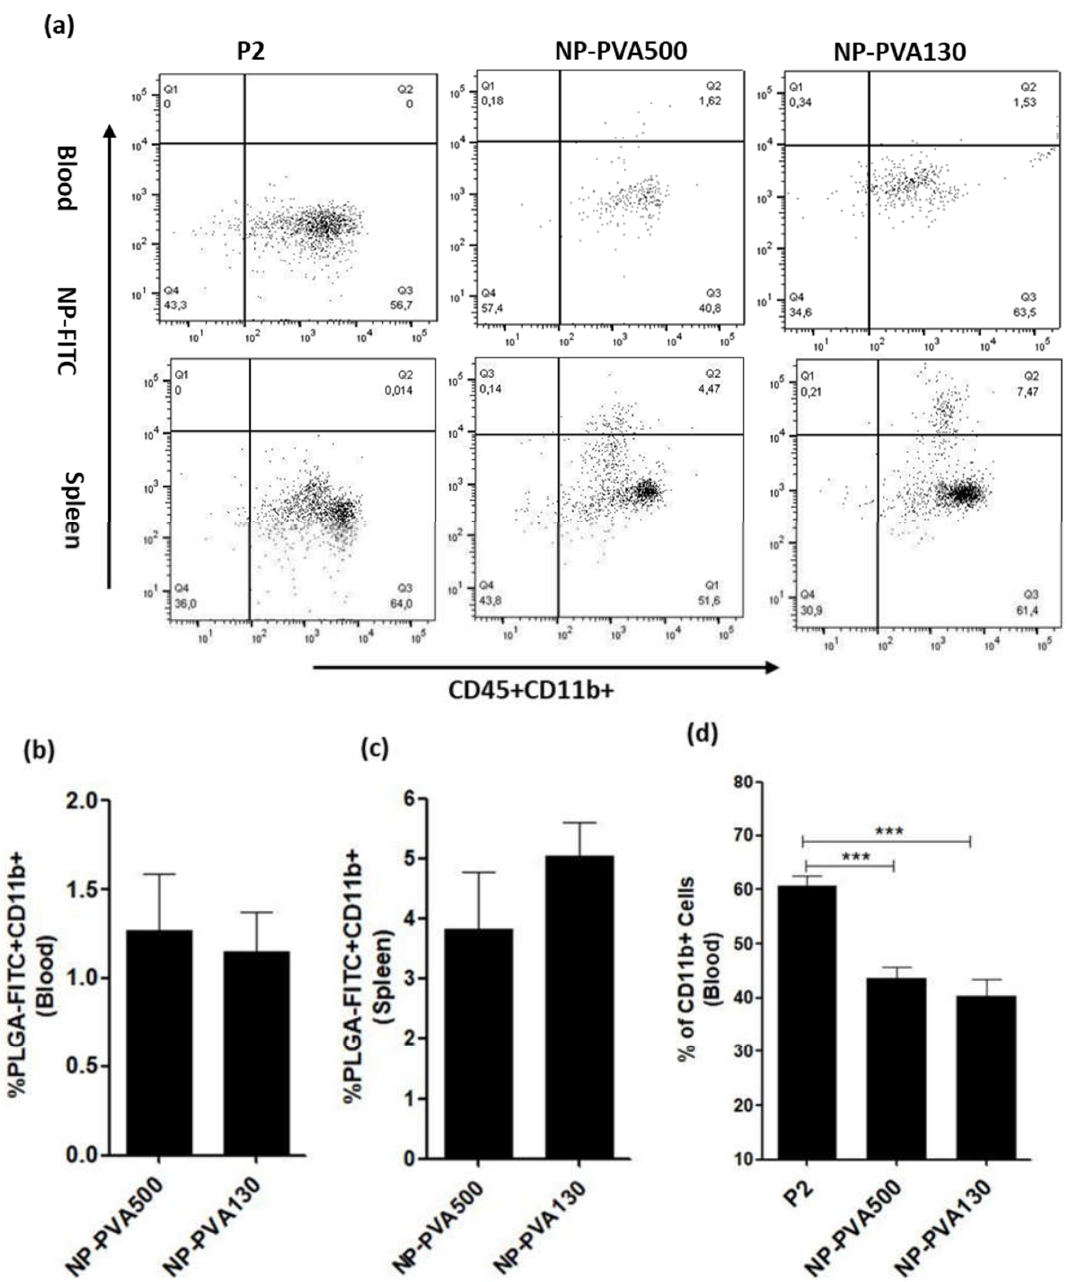
Figure 4. Dot plots of the flow cytometric representation of the percentage of the extent of NP-FITC+ monocytes: ( a ) Blood and spleen mononuclear cells (MNCs) were isolated from the P2-peptide and different sized NPs (NP-PVA500, NP-PVA130). For the treatment groups at day 17 of post immunizations, the percentage (Q2) of PLGA-FITC+CD11b+ cells of each group was determined. The data of the six animals is presented in the figure above. ( b , d ) Data of the percentage of the extent of NP-FITC+ monocytes of both in blood and spleen; ( b , c ) t -test (unpaired); ( d ) one-way ANOVA with a Bonferroni post-test, *** p ≤ 0.005.